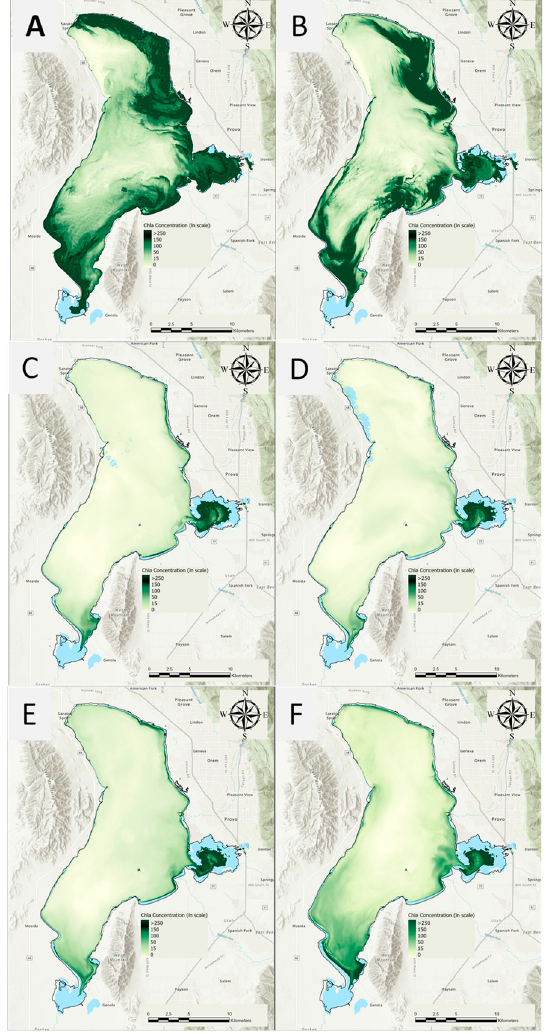
Figure 8. Example chl-a distributions in panels ( A , B ) for a Lake-wide bloom and a bloom on the eastern shore on for 22 July 1988 and 24 September 1988, respectively. Panels ( C , D ) show blooms developing in Provo Bay over an approximate two-week period on 31 August 2014, and 16 September 2014, 16 days later and show the bloom moving from Provo Bay into the Lake and up along the eastern shore. Panels ( E , F ) show blooms developing in Provo Bay and Goshen Bay on 3 September and two weeks later on 19 September 2021 which appears to show water with high chl-a concentrations flowing out from the large blooms in the two bays into the lake.